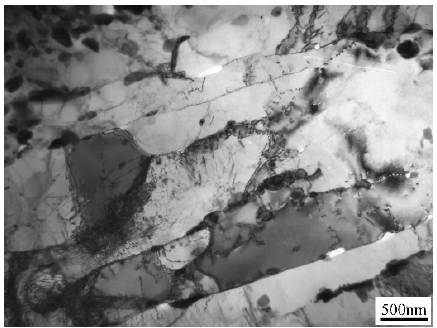
Figure 6. TEM image of the original microstructure of 9Cr-3W-3Co steel.